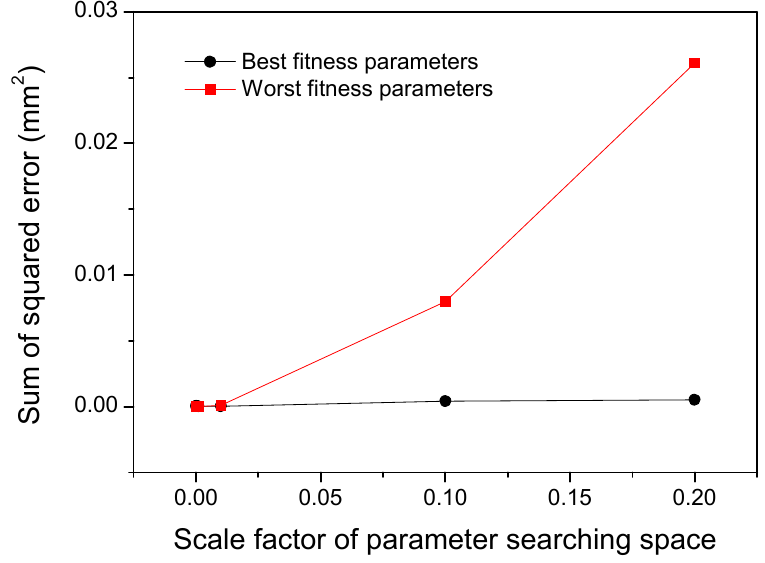
Figure 8. Fitness evaluation results of 50 sets of data not used in the parameter